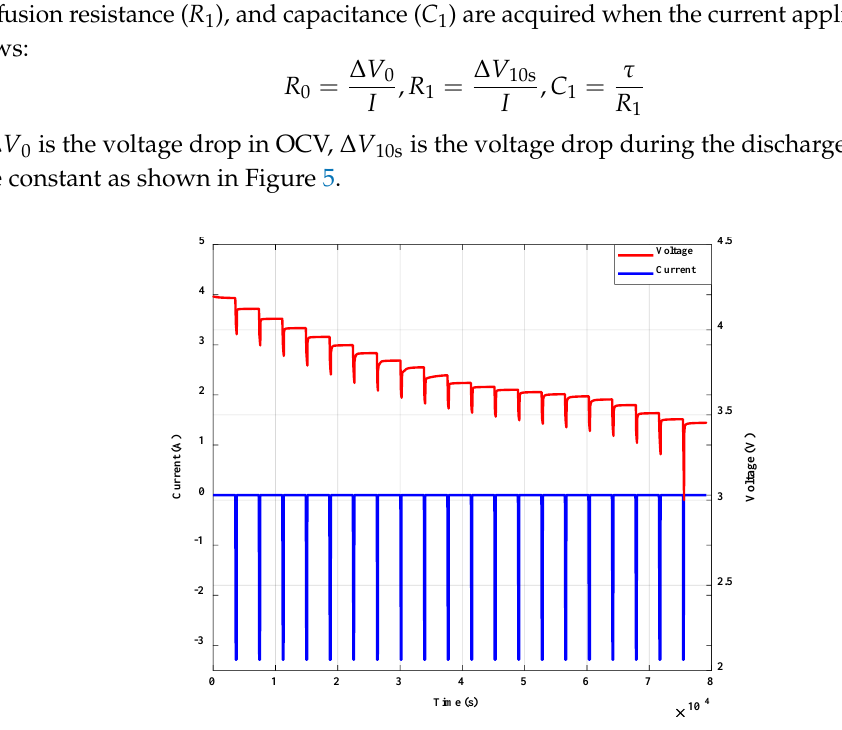
Figure 4. The battery state of charge (SOC) - open circuit voltage(OCV) test profile.